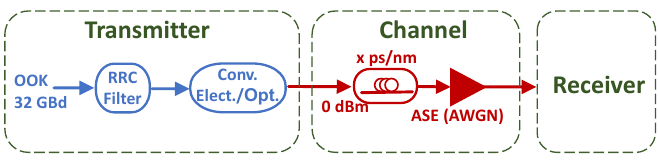
Figure 1. Simulation setup.